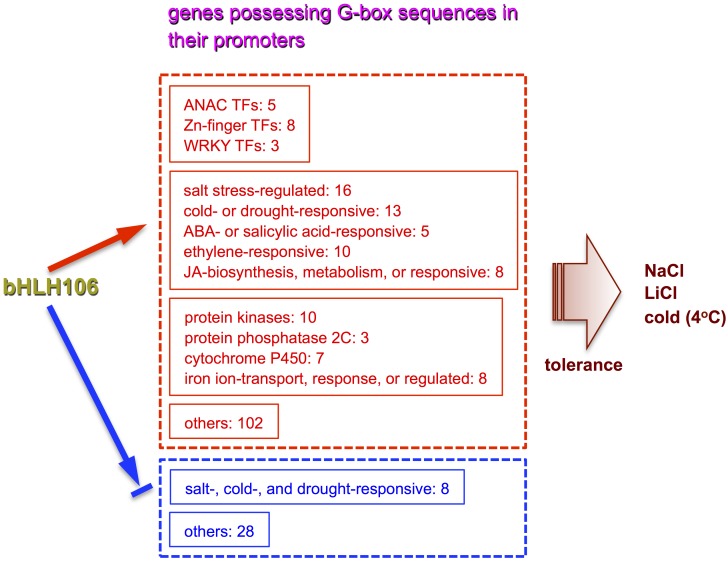
Representation of bHLH106 integrating functions of multiple genes through their G-box to confer salt tolerance on dedifferentiated cells of Arabidopsis.bHLH106 directly regulated 198 genes possessing G-box sequences positively, and 36 genes containing G-box ones negatively (S1 and S2 Tables). The up-regulated genes are classified into 12 different groups on the basis of functions (S3 Table). The down-regulated genes are categorized into abiotic stress-responsive ones and the others (S4 Table). The number at each gene group is that of members. The arrow shows positive regulation, and the arrow interrupted with a bar indicates negative regulation. Detailed functions of these genes are described in “S1 Discussion.”